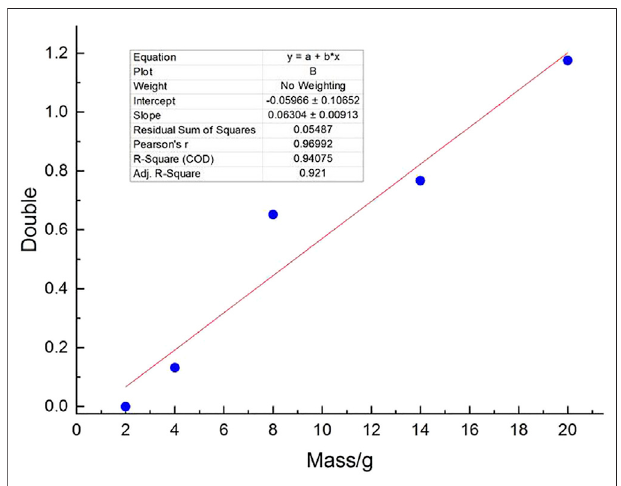
FIGURE 6 | Fitting result of the coincidence counting rate.